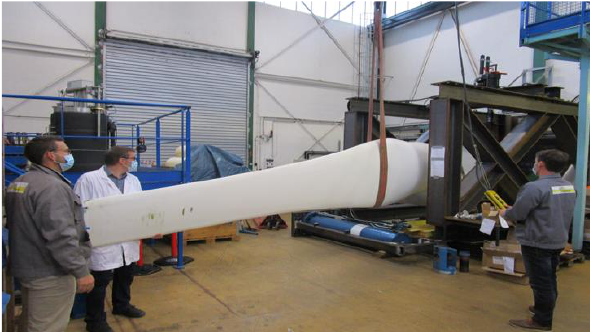
Fig.12. Blade installation on the test frame. The blade was modelled using ABAQUS ™ . Figure 13 shows the model together with an example of the predicted